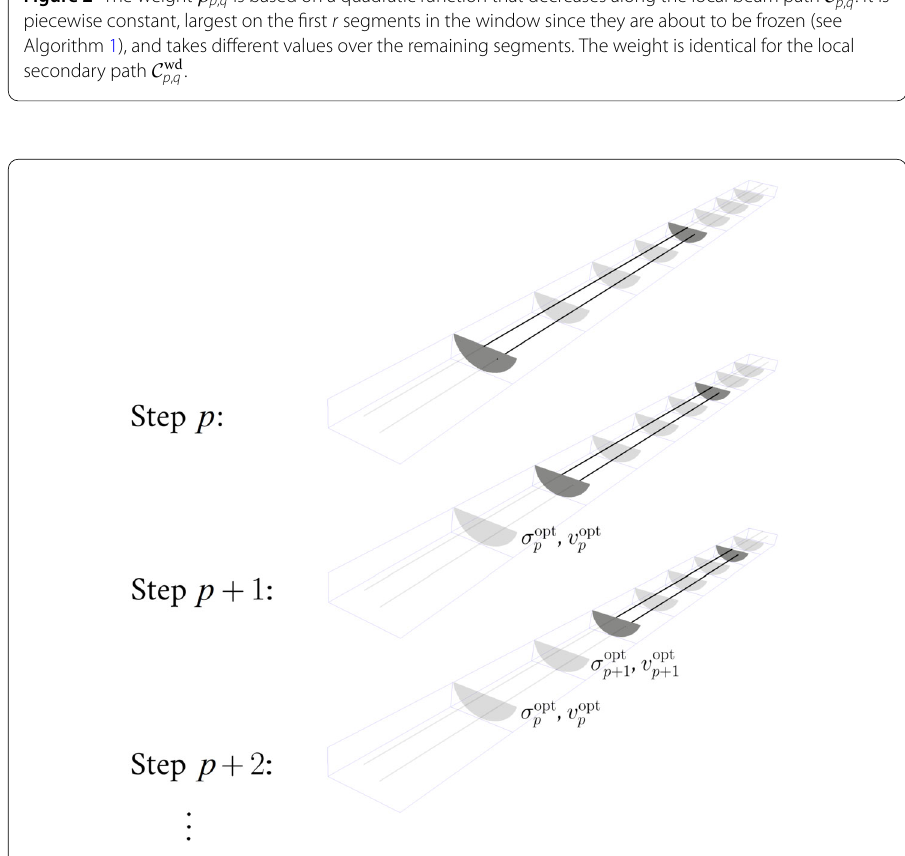
Figure 3 The greedy algorithm divides the optimization problem (6) into several smaller optimization problems that are easier to solve. The procedure involves a division of the beam path into subintervals. Localized optimization problems are solved on these intervals and optimal parameters are frozen in steps. After each such step, a new sub-problem is created by translating in time (ans space) and updating the initial condition. Here q = p + 3 and r = 1 (see Algorithm